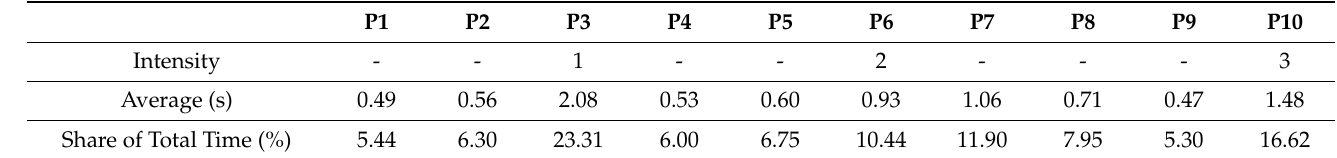
Table 1. Fixation times in the first category with background highlights. Source: own elaboration.